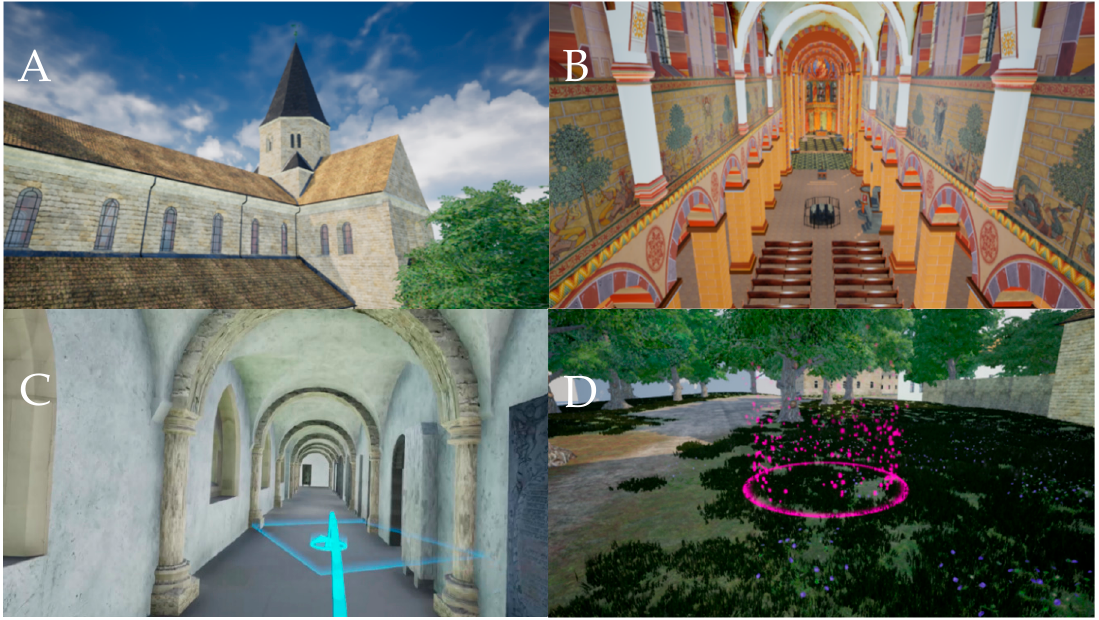
Figure 8. Two views of the Kaiserdom, inside ( A ) and outside ( B ). A third image ( C ) shows an example of the teleportation mechanic in action. Image ( D ) shows an example of a visual clue placed in the virtual world, where a panoramic photo can be viewed.